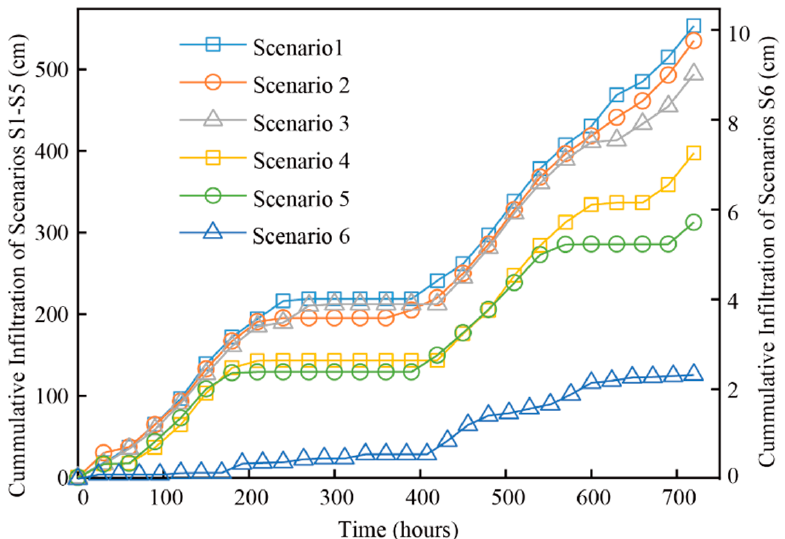
Figure 7. Water cumulative infiltration in each scenario.